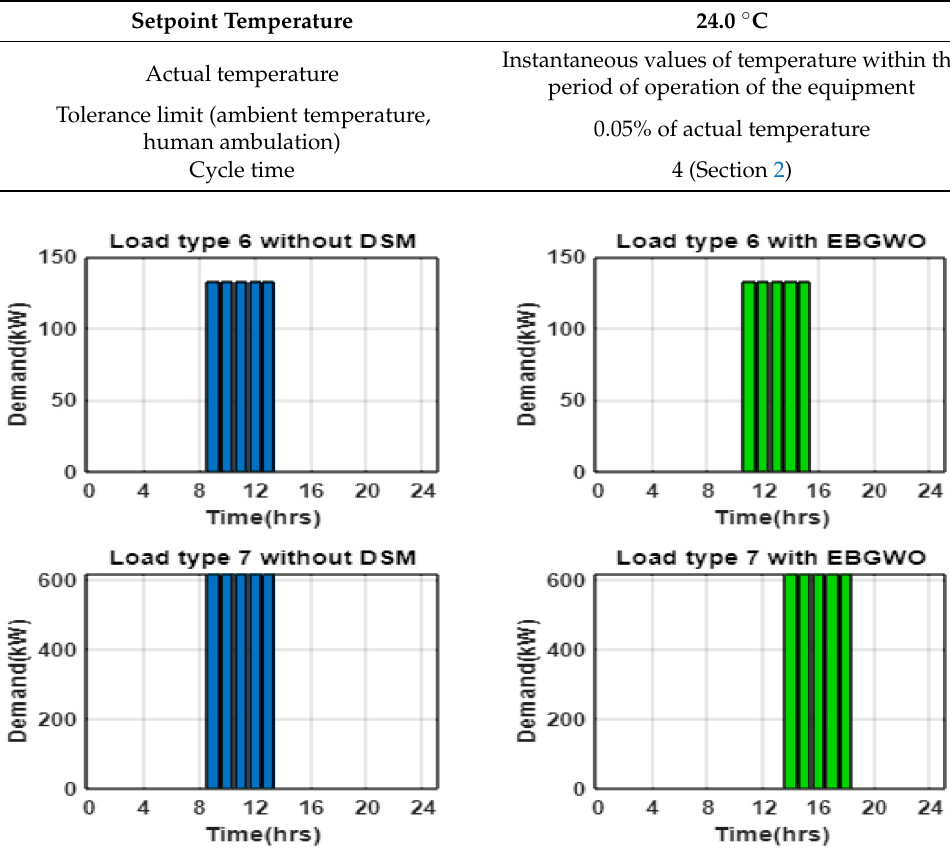
Figure 10. Shifting of load types 6 and 7 without DSM and with the proposed EBGWO.